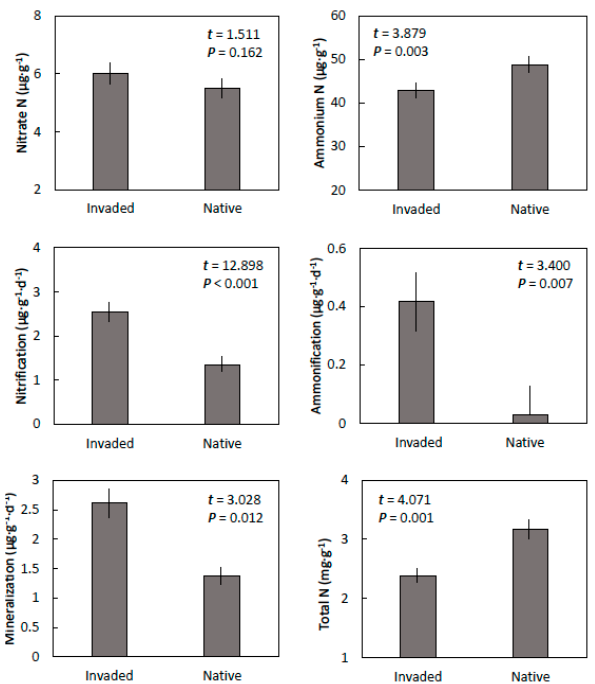
Figure 3. The nitrogen properties of coastal sand soils within invaded mature stands of. Leucaena leucocephala and in adjacent native forest in central Guam. Means ± SE, n = 6.